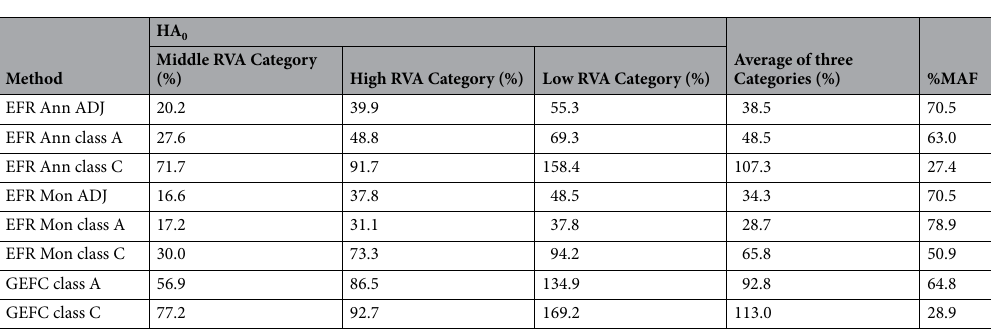
Table 4. Comparison of HA o value of conventional GEFC method with two new methods annual (EFR Ann) and monthly (EFR Mon) for different EMCs.